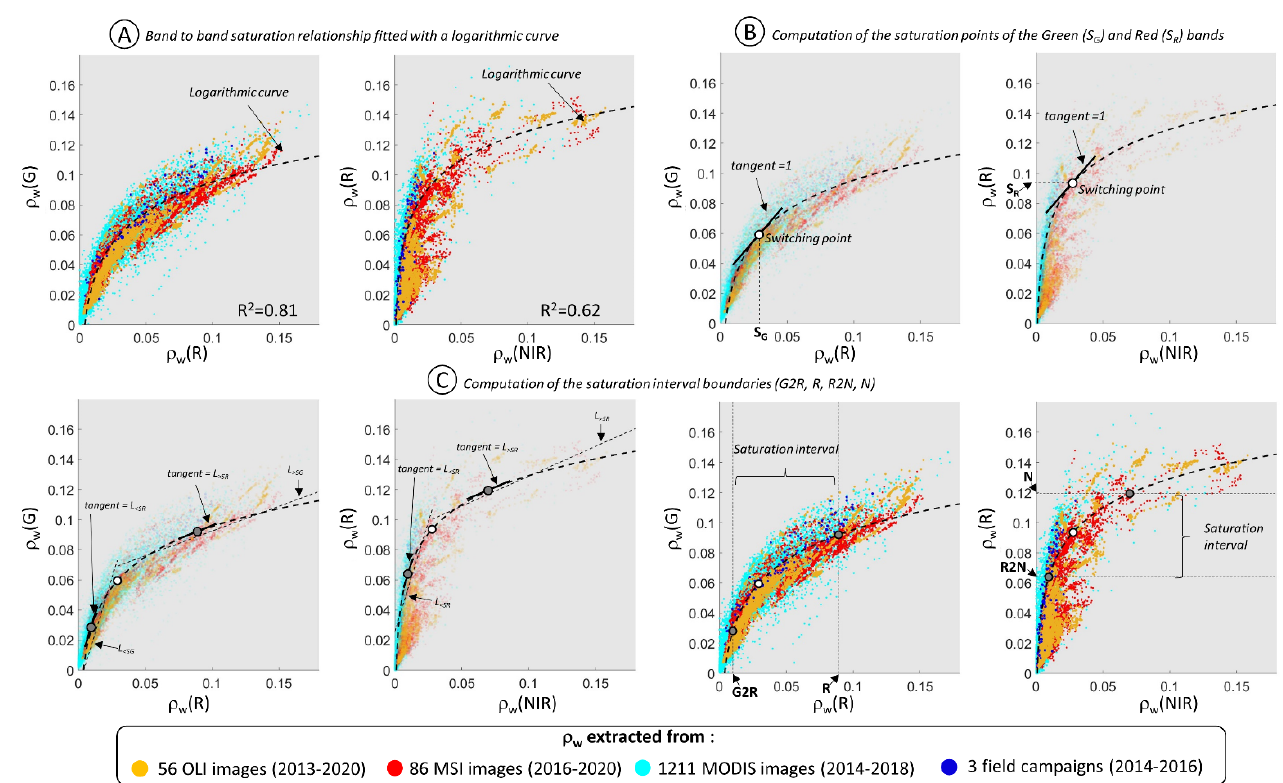
Figure A2. ( A ) Percentage of days covered by the MODIS dataset with respect to seasons. ( B ) Percentage of days covered by the MODIS dataset (blue bar) with dry (Q < 1500 m 3 .s − 1 ) and wet (Q > 1500 m 3 .s − 1 ) conditions compared to the outflow conditions over the 2005–2020 period (orange bar).